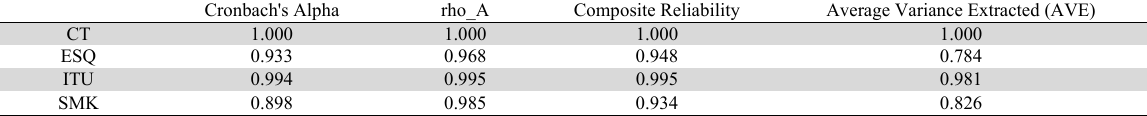
Cronbach’s Alpha, Composite Reliability, and Average Variance Extracted (AVE)